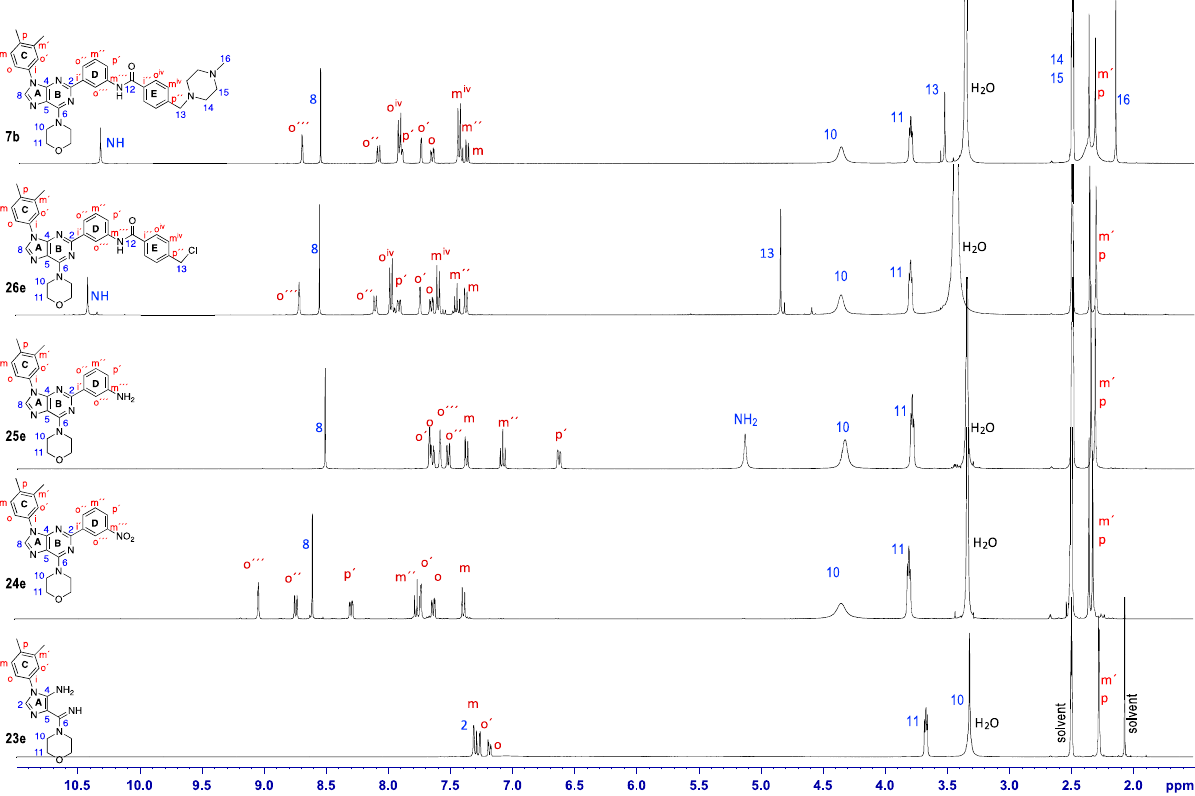
Figure 11. Spectra of 1 H NMR (DMSO- d 6 , 400 MHz) of model compounds with the assignment of signals to the corresponding protons in each structure.